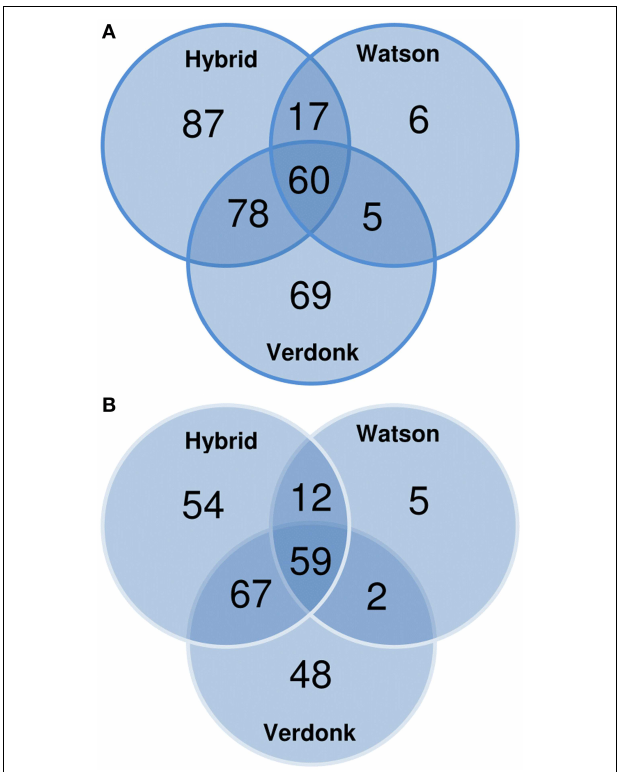
FIGURE 3 | Venn diagrams showing the repartition of the cell wall proteins (CWPs) identified by LC-MS/MS analysis according to (A) the NCBInr accessions and (B) the non-redundant Mt4.0v1 accessions obtained after blasting the NCBInr accessions on the Medicago truncatula genome.